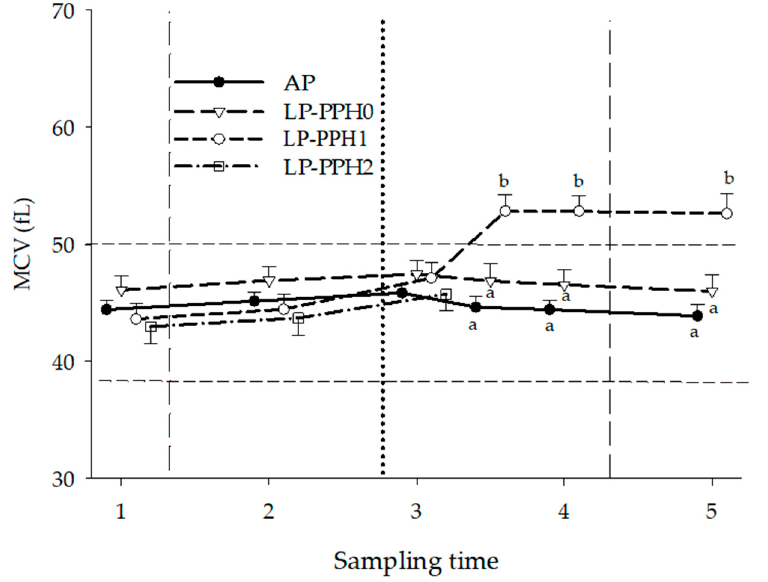
Figure 5. Mean corpuscular volume (MCV) of dairy cattle receiving a diet with adequate P content (AP, n = 18) or a P deficient diet (LP, n = 18) in the periparturient period. LP-PPH2: cows that developed clinical PPH (i.e., hemoglobinuria; n = 5), LP-PPH1: cows with subclinical PPH (n = 6); LP-PPH0: cows without evidence for PPH (n = 7). The vertical dashed lines mark the beginning and end of the phosphate depletion and repletion phase of the study. The vertical dotted line indicates calving. The horizontal dashed line presents the upper and lower limit of the reference range for MCV in cattle. Values with different superscripts differ from each other at that specific sampling time.